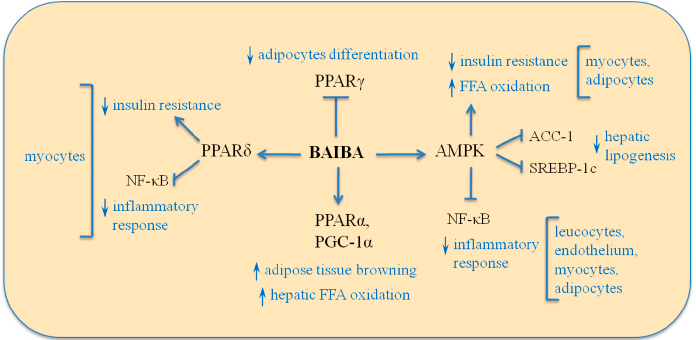
Figure 3. Signaling mediators of metabolic and anti-inflammatory effects of BAIBA. Multiple effects of BAIBA on metabolism and inflammation are mediated by activation of AMP-activated protein kinase (AMPK) and involvement of regulators of gene expression, such as peroxisome proliferator-activated receptors (PPAR) α / δ / γ , PPAR γ coactivator 1 α (PGC-1 α ), as well as transcription factors Nuclear factor kappa B (Nf- κ B) and Sterol regulatory element-binding protein-1c (SREBP-1c) . ACC-1 — acetyl-CoA carboxylase, FFA — free fatty acids.